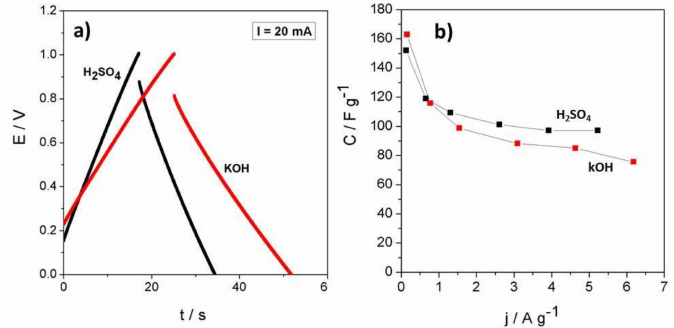
Figure 9. ( a ) Galvanostatic charge-discharge curves measured at 20 mA; and ( b ) specific capacitance vs. specific current measured in acidic and basic